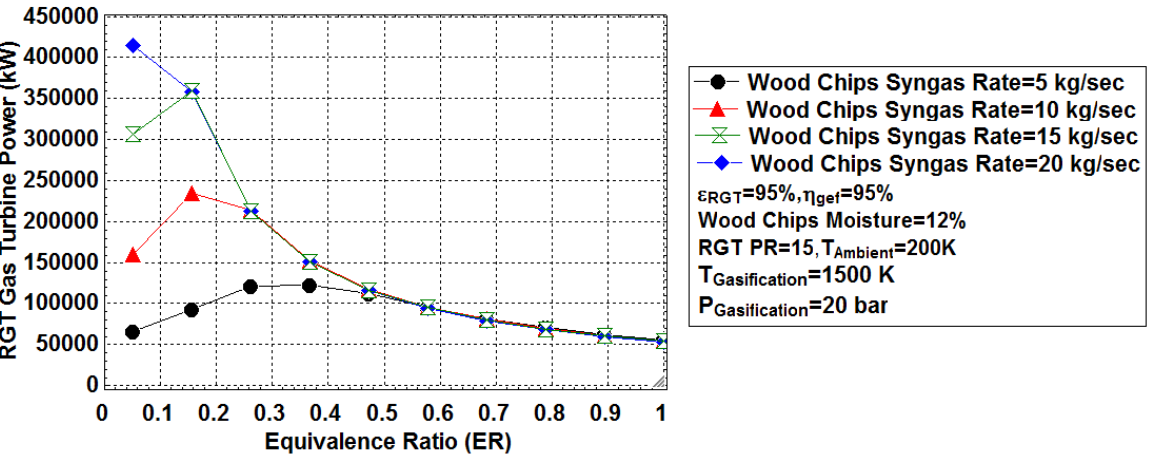
Figure 11. Effect of the rquivalence ratio on the RGT Power at different Wood Chip syngas rates.